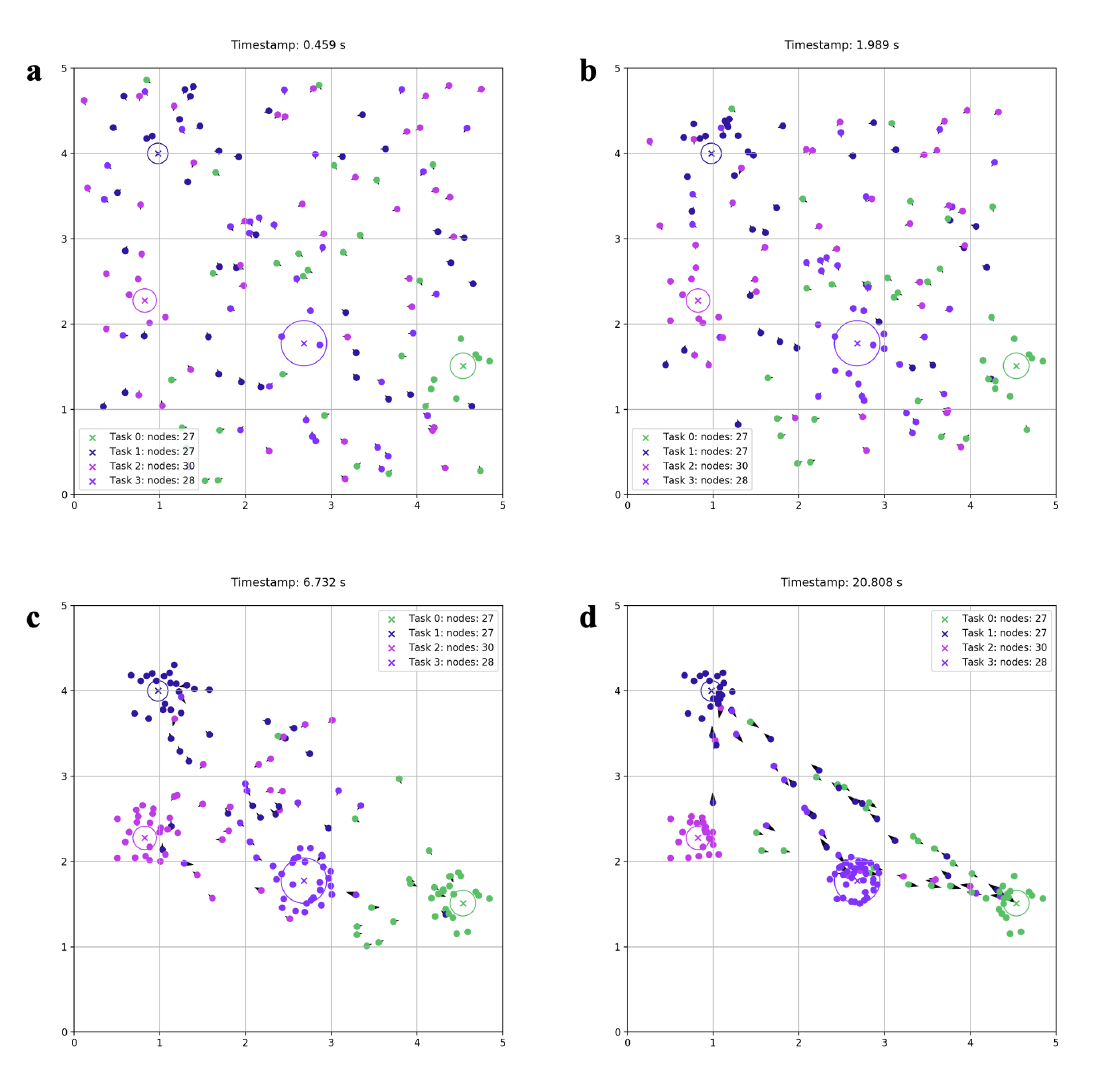
Figure 5. Illustration of a procession in time ( a – d ) of a simulation with 4 randomly placed tasks, with random radii, in a 5 × 5 unit field, where 150 nodes are placed at time 0 at random locations. In the legend “Task 0: nodes: 27” represents a task with ID 0 and expected 27 nodes to